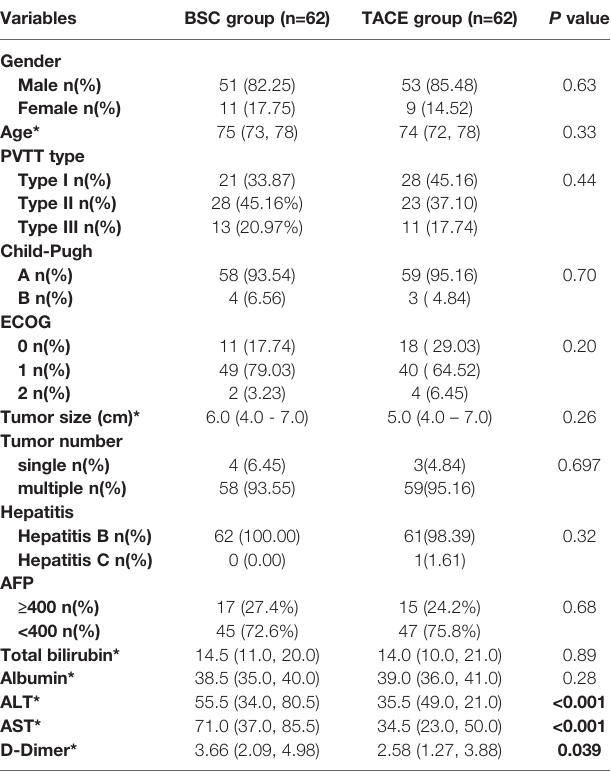
TABLE 1 | Baseline characteristics of elderly HCC patients in the BSC group and the TACE group.